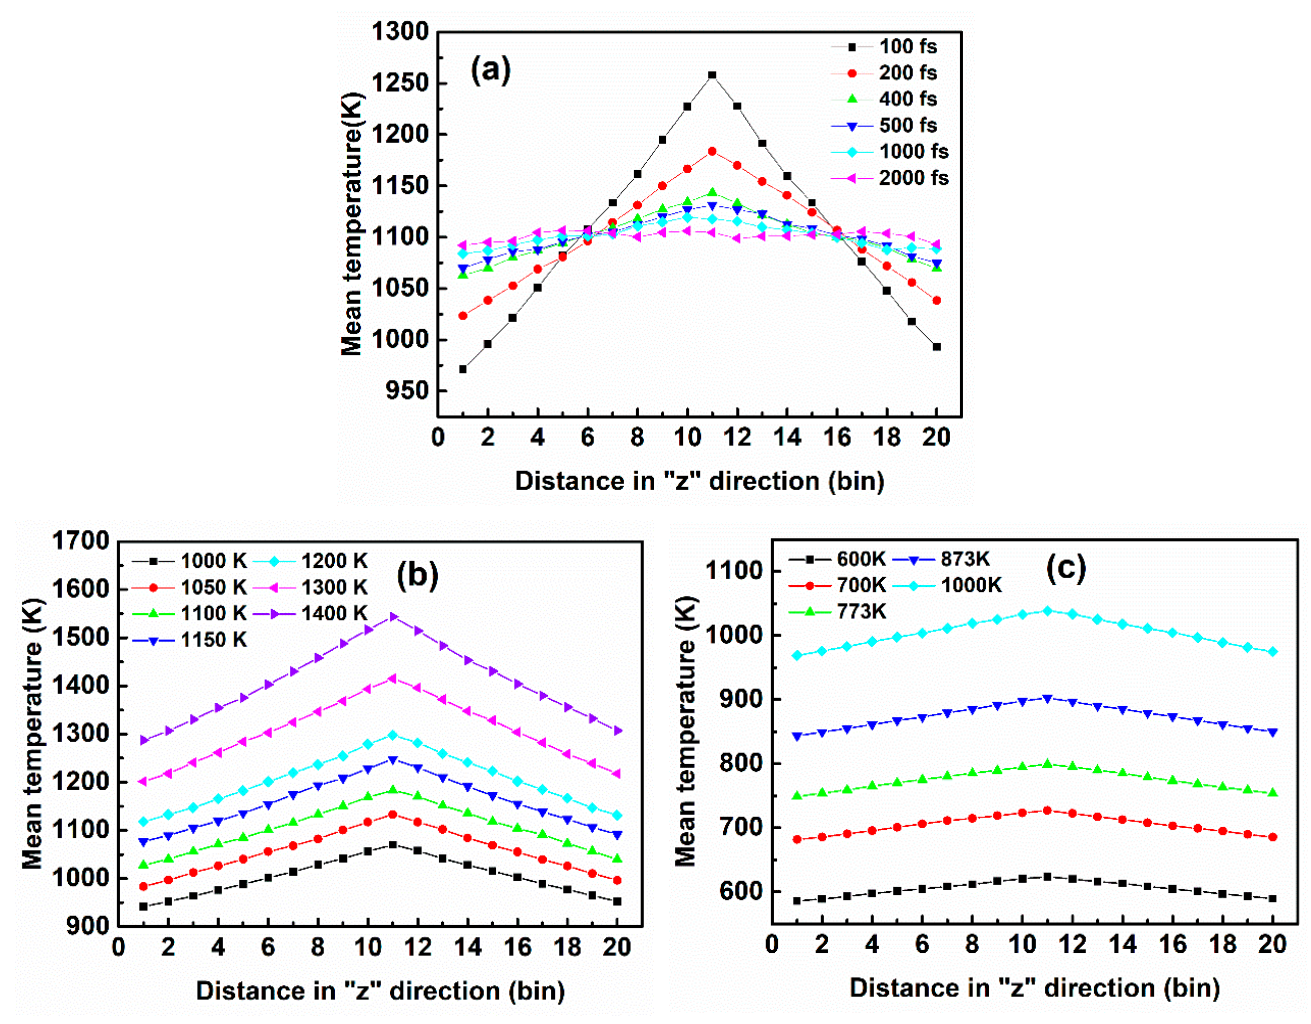
Figure 7. Mean temperature gradient in different temperature with kinetic energy swap rate: ( a ) Different swap rates; ( b ) MgCl 2 at 400 time steps; ( c ) ZnCl 2 at 400 time steps.